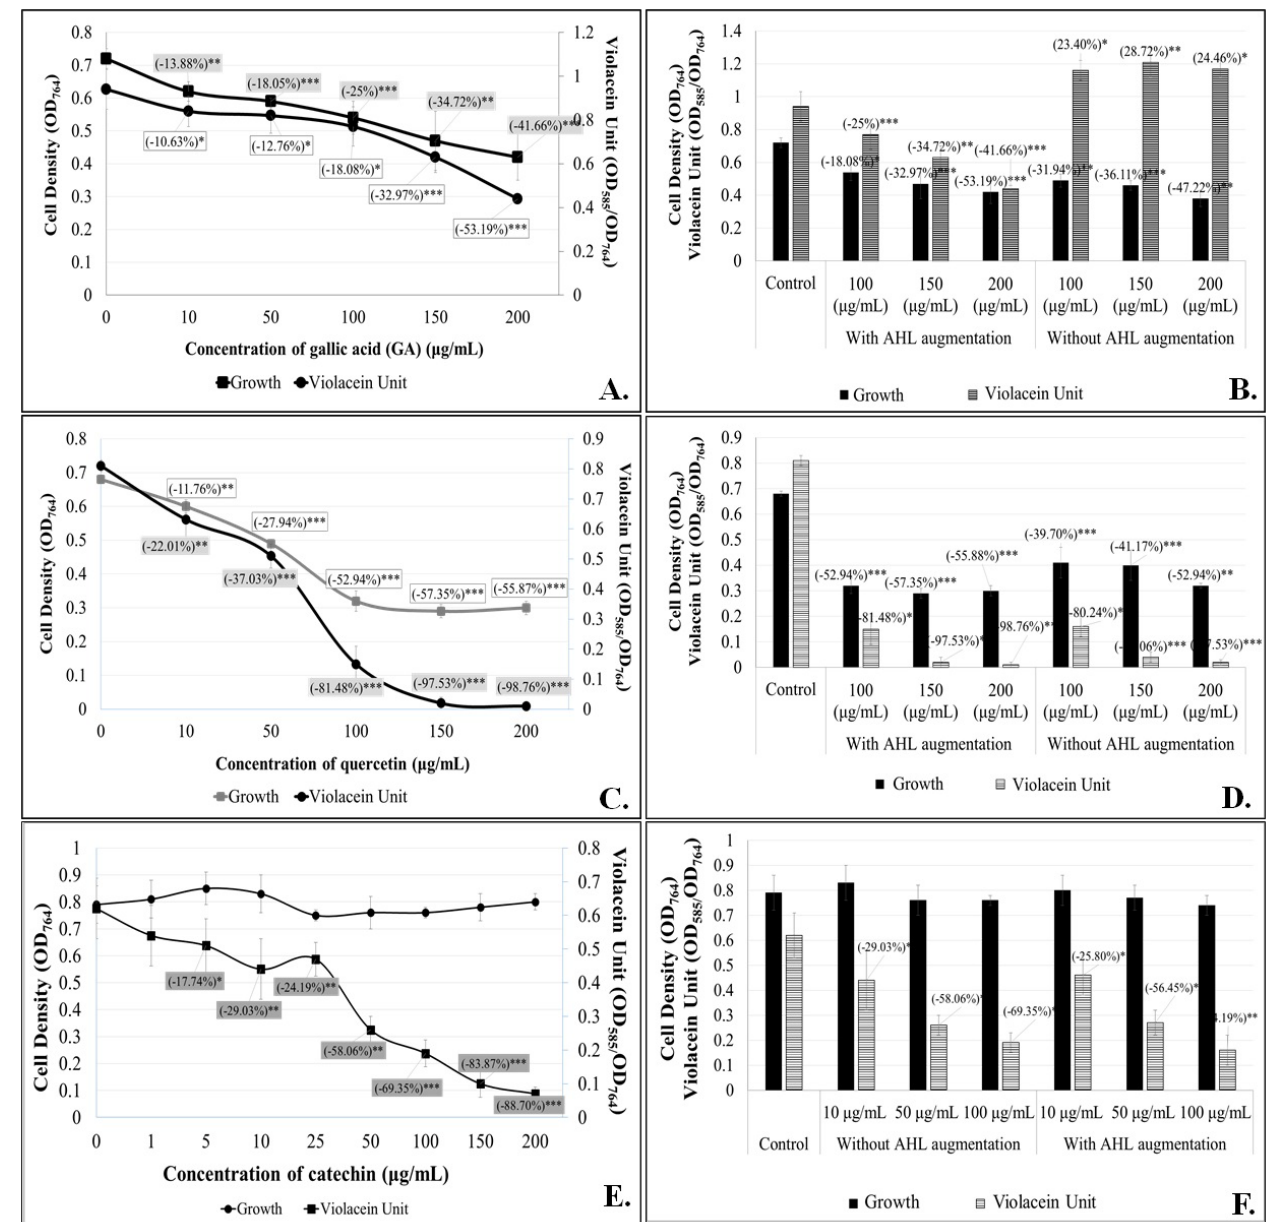
Figure 6. Effect of GA, quercetin, and catechin on C. violaceum . Bacterial growth was measured as OD at 585 nm, and Violacein Unit was calculated as the ratio OD figure is the vehicle control (0.5%v/v DMSO), which did not exert any effect on growth and violacein production of C. violaceum. ( A ) Effect of gallic acid on growth and violacein production in C. violaceum. ( B ) GA acts as a signal-supply inhibitor. ( C ) Effect of quercetin on growth and violacein production in C. violaceum . ( D ) Quercetin acts as a signal-response inhibitor. ( E ) Effect of catechin on growth and violacein production in C. violaceum. ( F ) Catechin acts as a signal-response inhibitor. *p<0.05, **p<0.01, ***p<0.001. QS, quorum sensing; GA, gallic